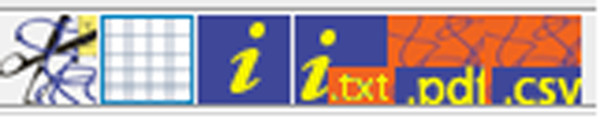
Menubar buttons appearing on child windows. Here showing: Cut, Tabulate, Get info, Export info as .txt, Export graphic as .pdf, Export dataset as .csv.